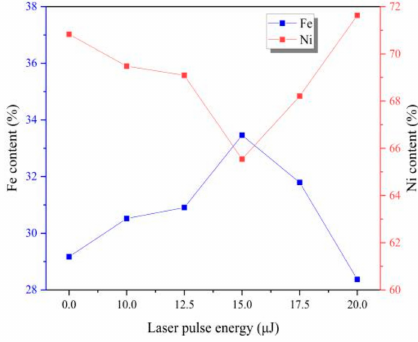
Figure 4. Chemical composition of coatings with varying laser energies.